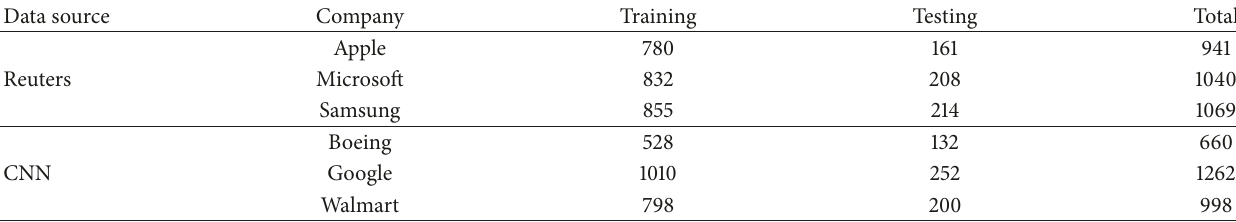
Table 4: Training and testing datasets.